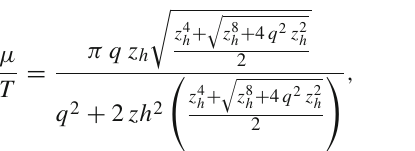
Fig. 6 dt ex as a function of μ . Left: We fixed the values of interquark T d μ T distance l = 0 . 27, the transition time k = 0 . 3 and the temper- ature T = 0 . 37 ( lT = 0 . 10). The blue curve is the function, ( π − μ ) − θ , fitted with the data with θ = 0 . 515667. Right: √ T 2 2